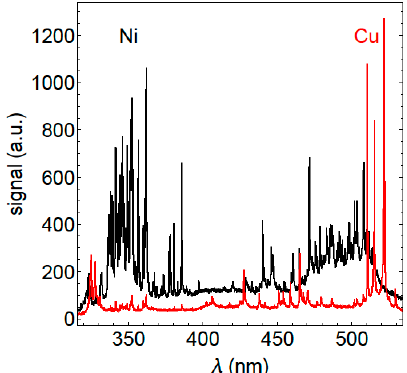
Figure 2. Spectrum of the plasma of a Ni coated copper sample, created with a burst of five 10 ps laser pulses. The black spectrum shows the second recorded spectrum, the red spectrum shows the 200th recorded spectrum. In order to measure the layer thickness at one position of the sample, about 100 bursts of laser pulses are used to ablate the coating. Figure 3 shows the intensity at the position of the copper lines (red) and the nickel lines (black) as a function of laser pulses.